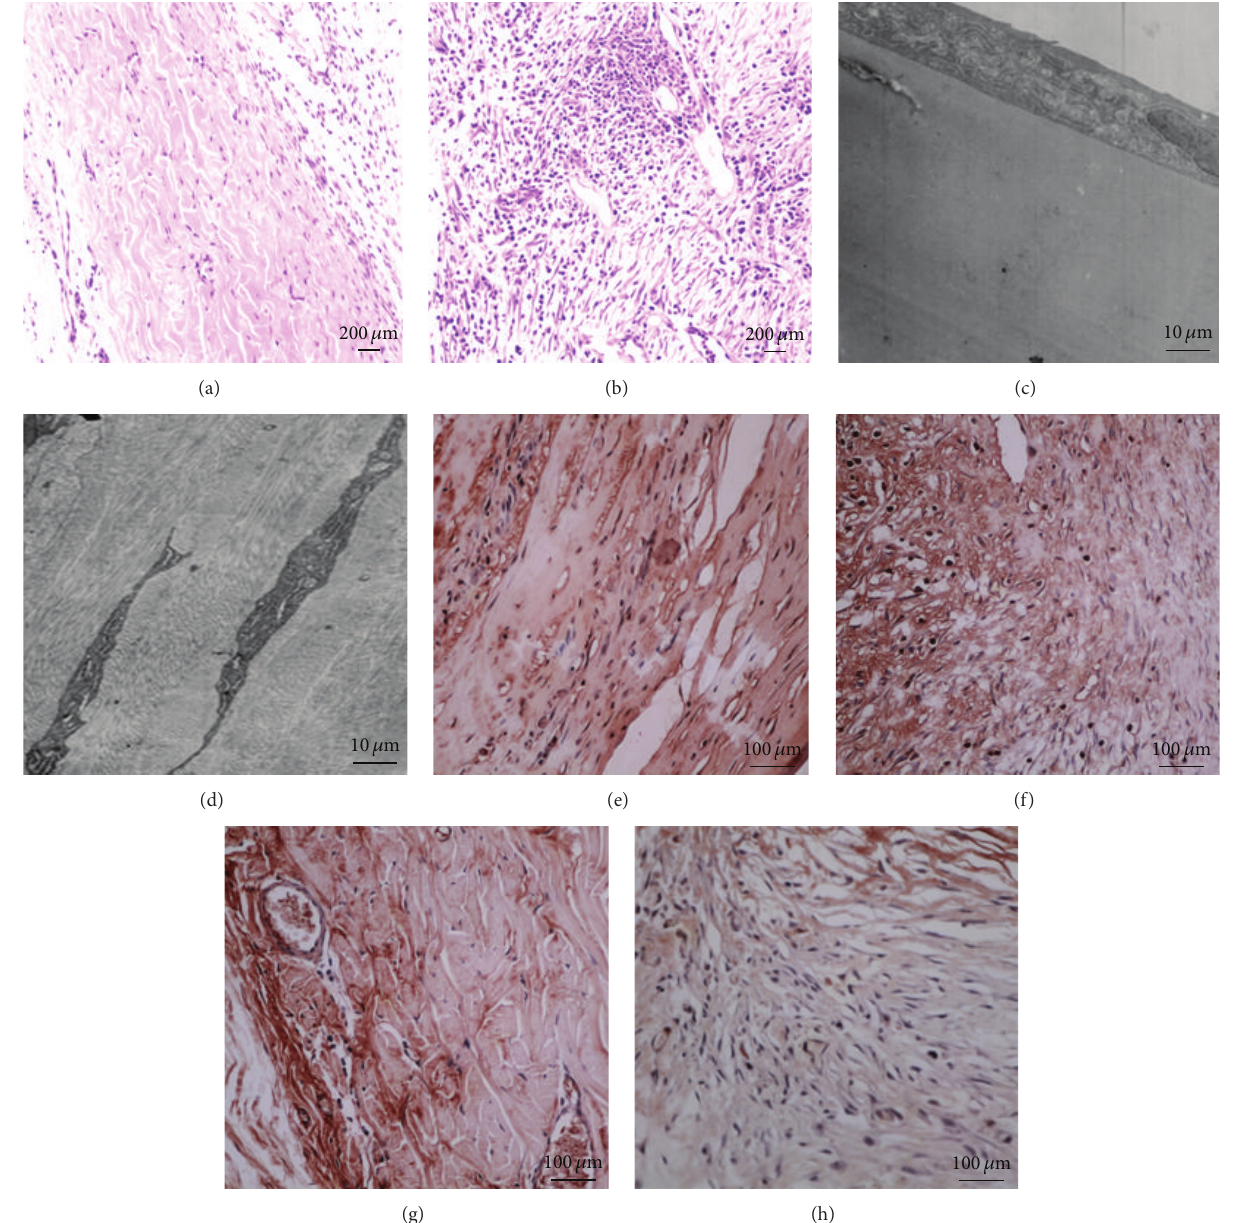
Figure 3: Histopathology of retroprosthetic membrane extracted from the explanted keratoprosthesis in the corneal alkali-burned rabbits. H&E staining of normal cornea ((a) × 100) and retroprosthetic membrane ((b) × 100); transmission electron microscopy of normal cornea ((c) × 4000) and fibrous retroprosthetic membrane ((d) × 4000); immunohistochemical analysis of MMP-9 ((e) × 200) and TIMP-1 ((f) × 200) expressions in normal cornea (MMP-9: (e) × 200; TIMP-1: (g) × 200) and retroprosthetic membrane (MMP-9: (f) × 200; TIMP-1: (h) ×